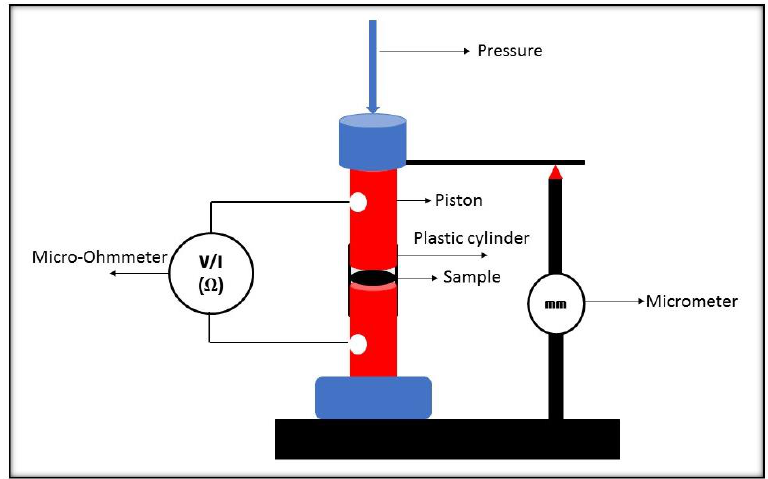
Figure 1. Laboratory electrical conductivity measurement setup.